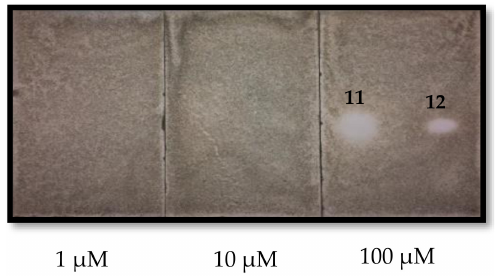
Figure 4. Thin layer chromatography bioautography antifungal results for confertin ( 11 ) and neoambrosin ( 12 ) at varying concentrations after spraying with spore suspensions of Colletotrichum fragariae